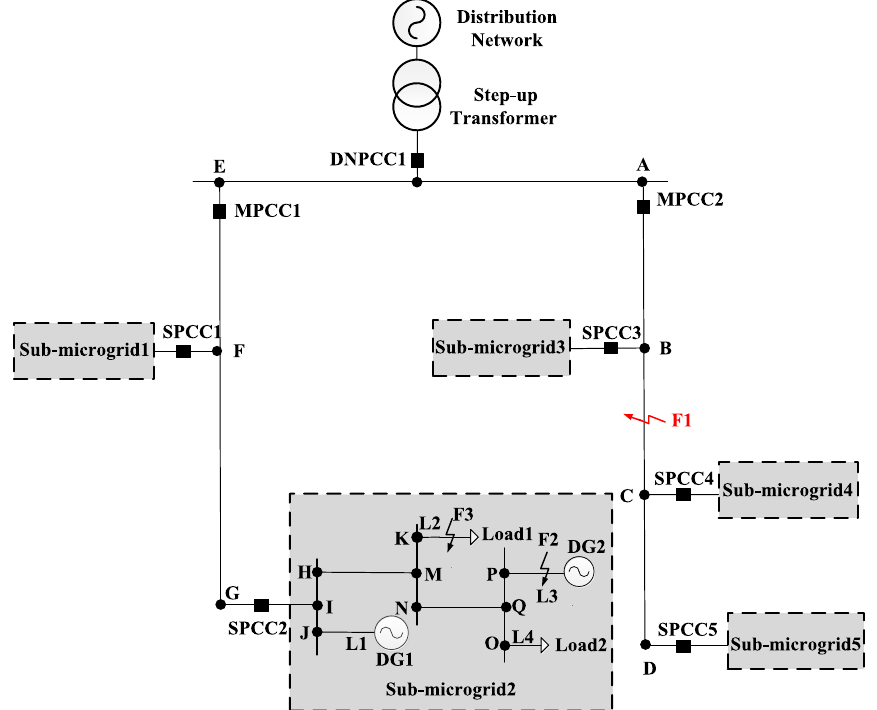
Fig. 2 Simplified structure of multi-microgrid system